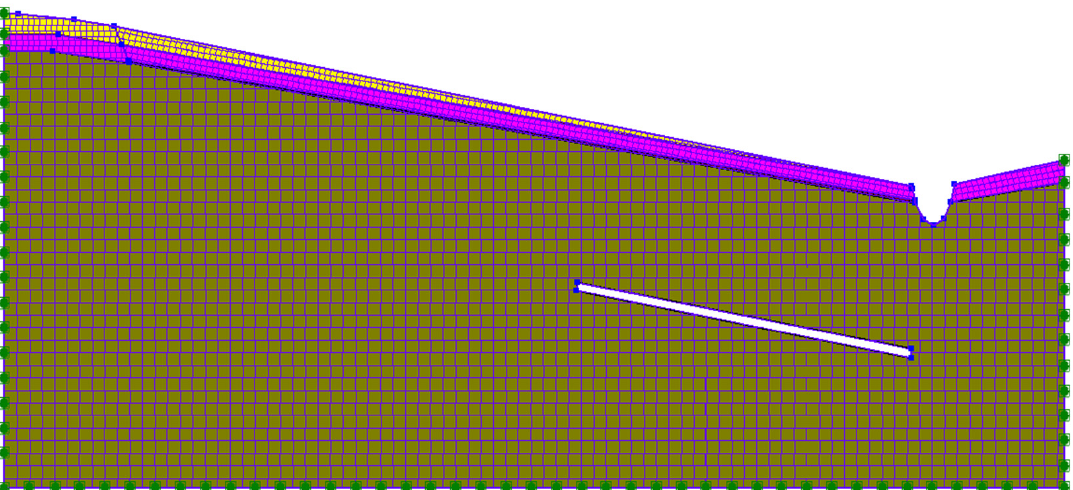
Figure 3. Discrete element model of the slope before the landslide in the Tanshan Coal Mine.